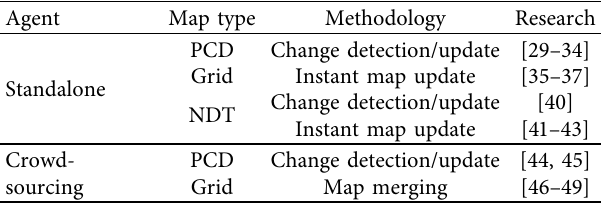
Table 1: Categorization for researches of LiDAR map